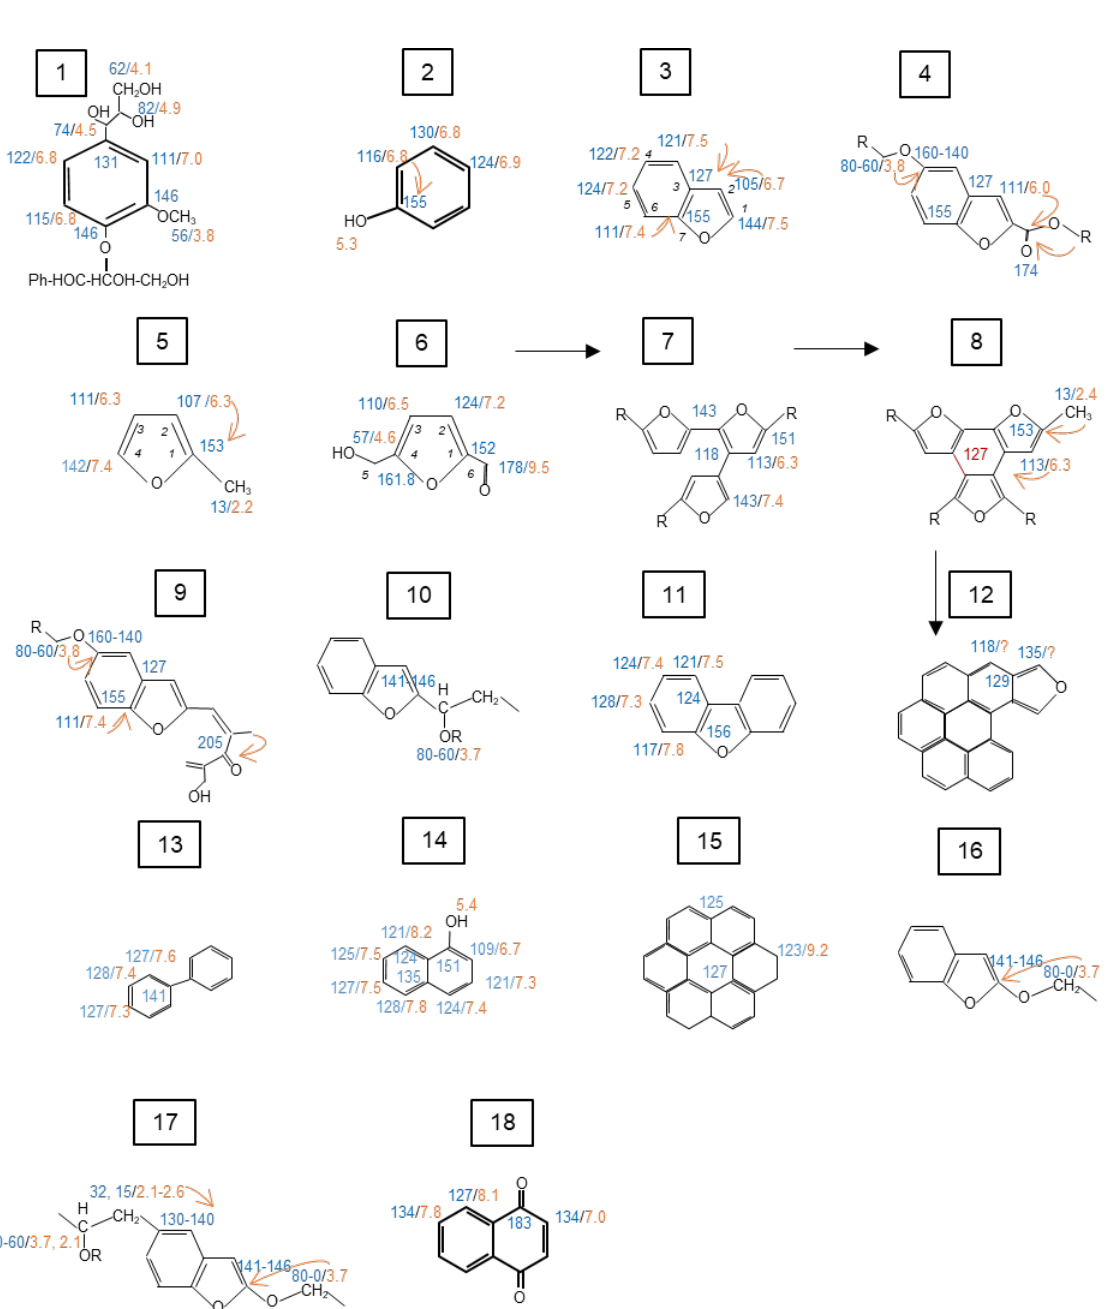
Figure 4. Chemical structures (1–18) that are potentially present in the pyrochar produced from cellulose pyrolyzed at 350 °C for 1 h. Their 13 C chemical shifts are given in blue and their 1 H chemical shifts are indicated in orange. Potential cross polarization of unprotonated carbons by neighboring protons of adjunct carbons are indicated by orange arrows. The chemical shift assignments were obtained from literature values [23,36,45 – 48] and https://www.chemicalbook.com (accessed on 20 January 2021) .